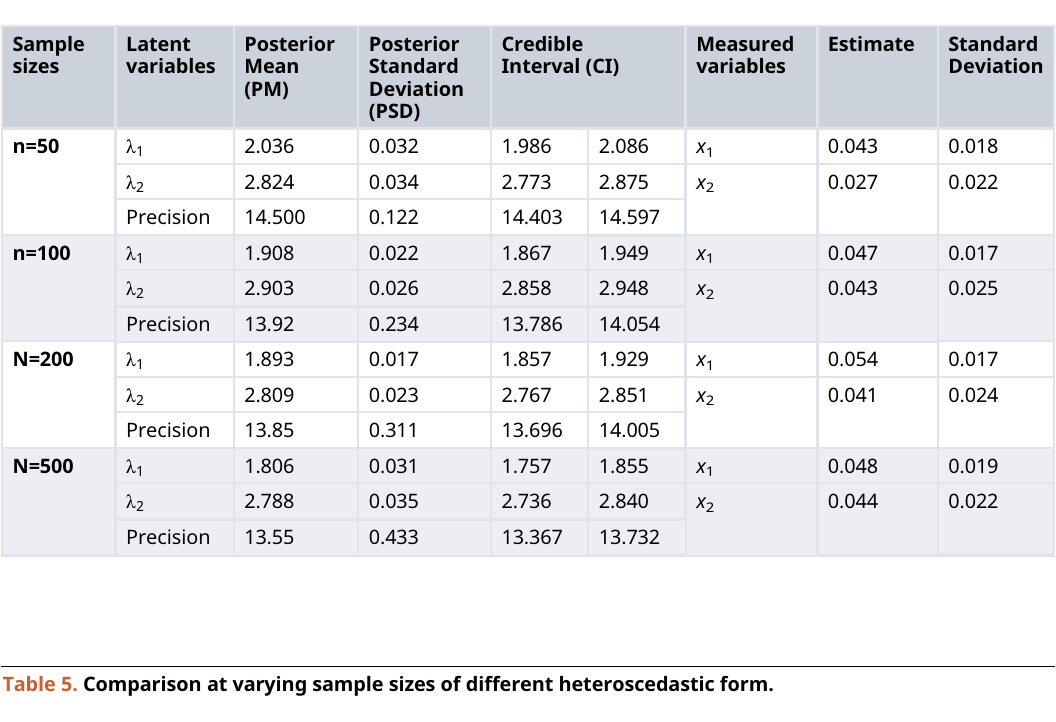
Table 4. Linear absolute form on latent variable and observed variable estimates.